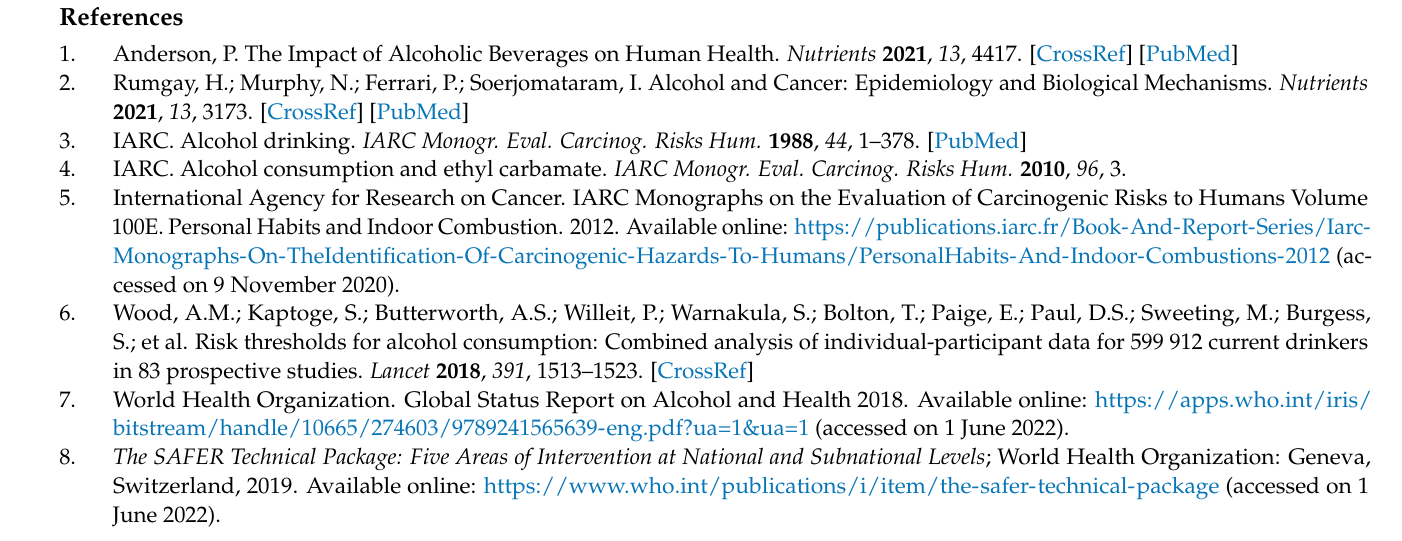
scale) of wines for each calendar day by ABV group summed across 18,954 Spanish households; Figure S9: Plots of mean number of purchased bottles per day of purchase (adjusted to 700 mL) per study day (adjusted over each week) of any variant of the whisky or gin for regular strength products and 20% ABV products summed across 18,954 Spanish households). Table S1: Divisions of households by socio-demographic characteristics.(N = 18,954